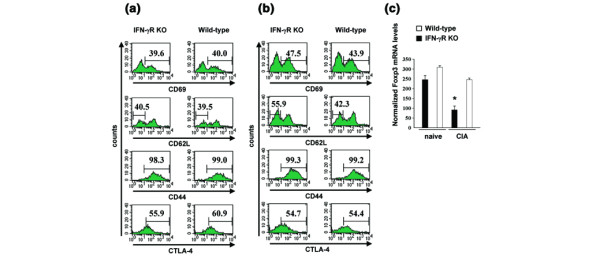
Phenotypic characterisation of CD4+CD25+ T cells from immunised IFN-γR KO and wild-type DBA/1 mice. (a, b) CD4+CD25+ T cells isolated from IFN-γR KO and wild-type mice show a similar expression pattern of activation markers, in naive (a) and immunised (b) conditions. CD4+ T cells were purified from the lymph node cells of eight IFN-γR KO and wild-type DBA/1 mice, either naive or having been immunised 21 days previously with collagen type II in complete Freund's adjuvant (purity more than 99%). CD4+ T cells were stained for CD25 in combination with CD69, CD62L, CD44 or cytolytic T lymphocyte-associated antigen-4 (CTLA-4). Dead cells were excluded by gating on propidium iodide-negative cells. The numbers represent the percentages of CD4+CD25+ cells within the indicated marker. (c) Decreased Foxp3 mRNA levels in CD4+CD25+ Treg cells from immunised mice. Lymph node cells were isolated from eight naive or immunised IFN-γR KO and wild-type DBA/1 mice. Purified CD4+ T cells were stained with anti-CD25-FITC and phycoerythrin-conjugated anti-CD4, and sorted. The purity of the sorted CD4+CD25+ population was more than 97%. cDNA samples were prepared from 2 × 105 cells of each population and were subjected to real-time quantitative PCR analyses. The relative quantity of Foxp3 in each sample was normalised to the quantity of β-actin. Error bars indicate standard error of the means of two (CD4+CD24+ cells from naive mice) or three (CD4+CD25+ cells from immunised mice) independent experiments. *P < 0.05 for comparison with Foxp3 expression of cells isolated from immunised wild-type mice (Mann–Whitney U-test).